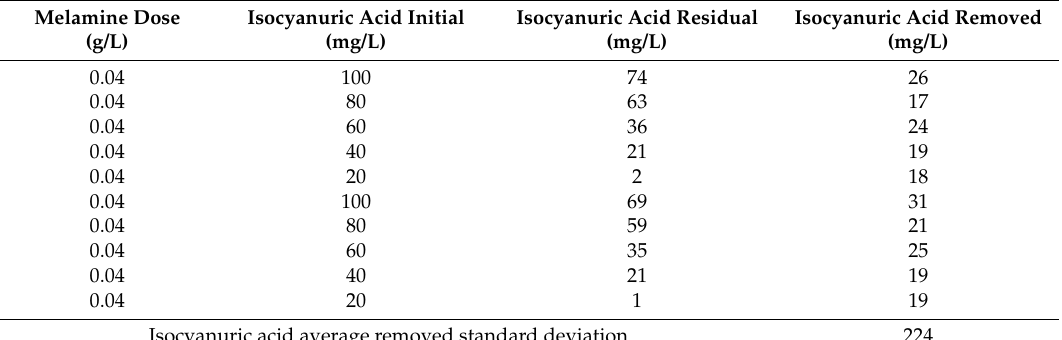
Table 1. Results of isocyanuric acid after addition of a constant dose of melamine and removal of isocyanuric acid.